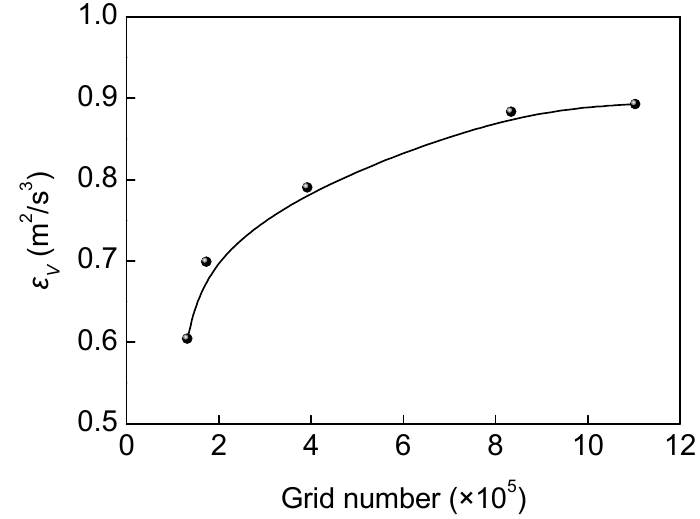
Figure 2. Grid independence verification.